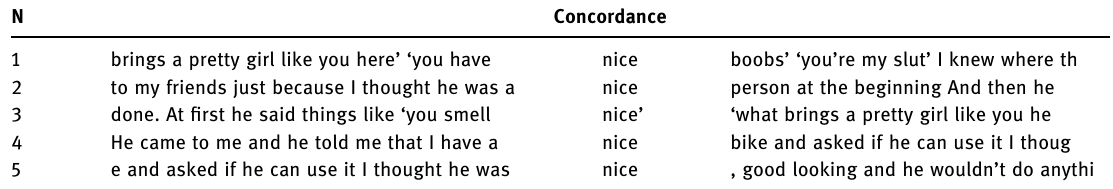
Table 9: Concordance lines for nice N Concordance